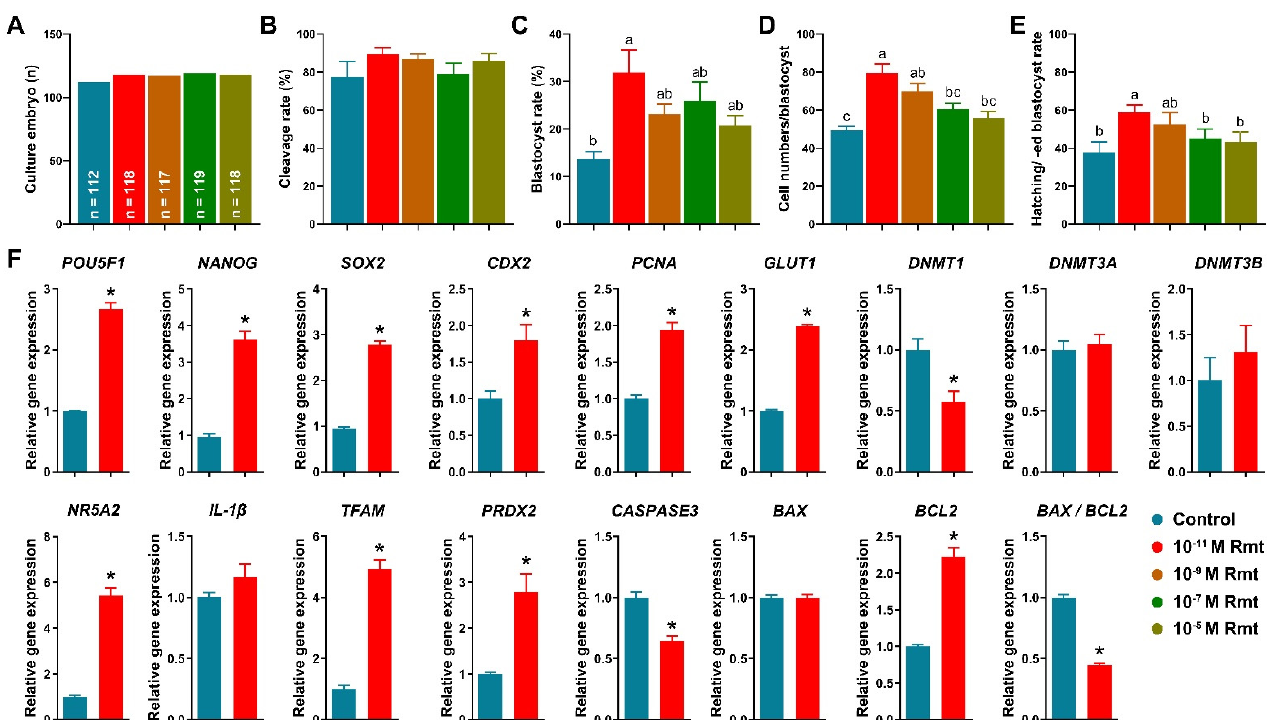
Figure 3. Early embryonic development after parthenogenetic activation and embryo development − related gene expression. ( A ) Culture number of embryos; ( B ) cleavage rate; ( C ) blastocyst formation rate; ( D ) total cell numbers per blastocyst; ( E ) hatching/ − ed blastocyst rate; ( F ) Expression of embryo development − and apoptosis − related genes in blastocyst. Within the same indicator, different letters or asterisks denote significant difference ( p < 0.05). Results are shown as the average ± SEM of at least three repeats of independent experiments. Rmt, Ramelteon.